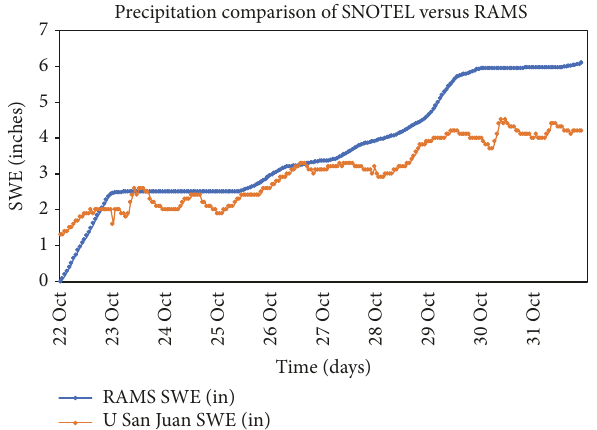
Figure 8: Plot for comparison of SNOTEL and RAMS snow water equivalent for Case Study 1. Solid red line: RAMS, crossed green line: SNOTEL.